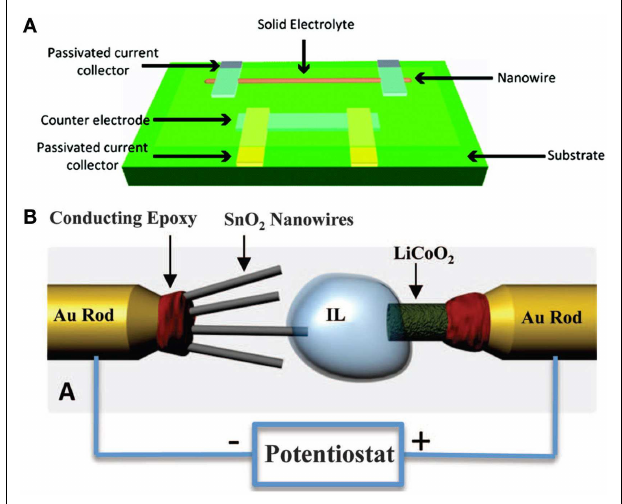
FIGURE 1 | (A) Schematic diagram of a single nanowire electrode device design (Mai et al., 2010a). (B) Schematic of the in situ TEM setup (Huang et al., 2010). Reprinted with permission from Huang et al. (2010) and Mai et al. (2010a). Copyright 2010 American Chemical Society, 2010